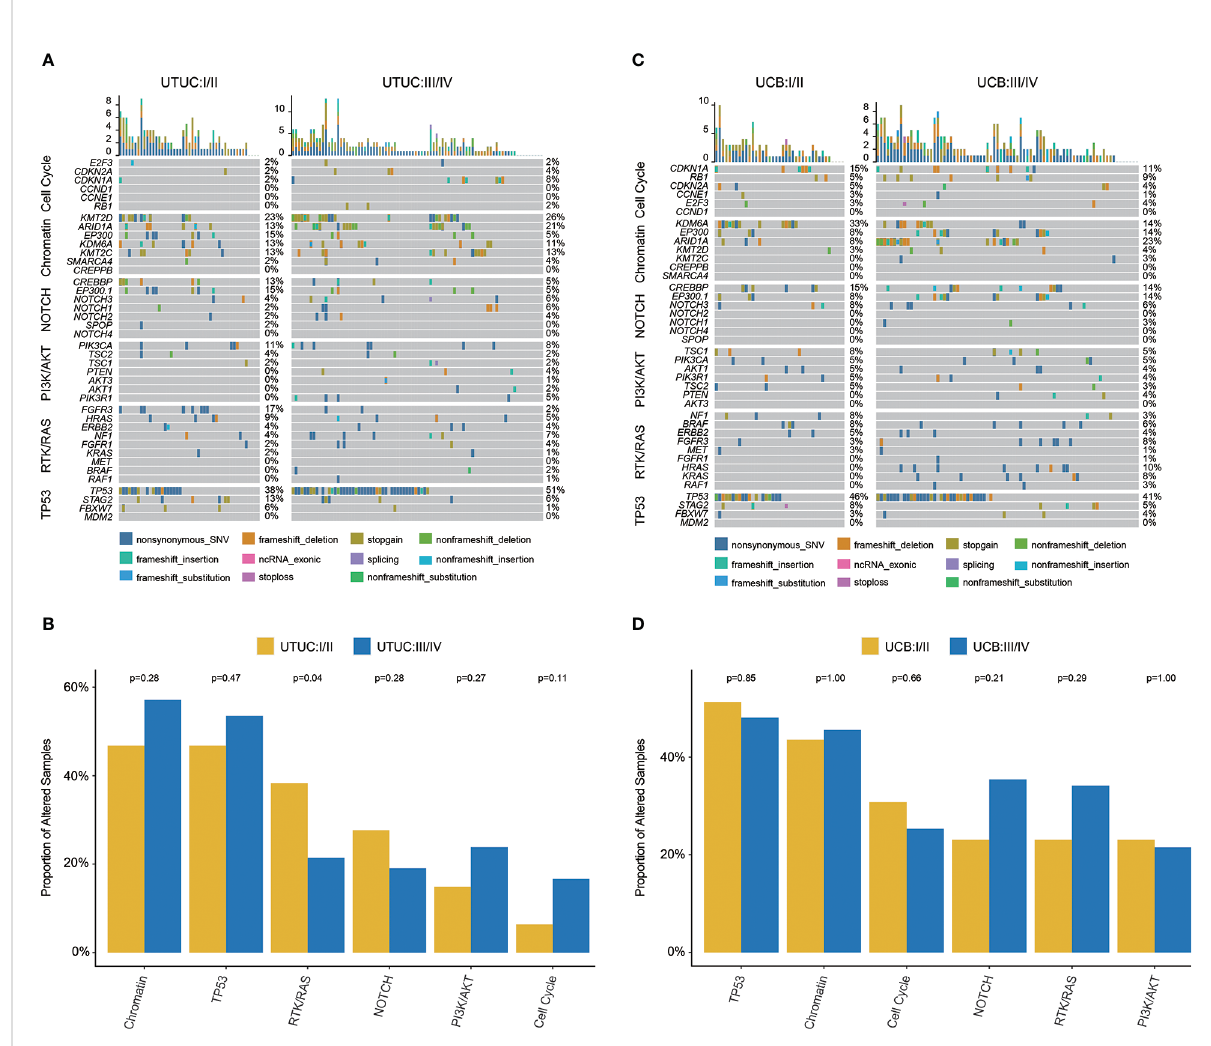
FIGURE 4 Genomic landscape, strati fi ed by clinical stages and molecular pathways, of Chinese UTUC and UCB. (A) Differences of prevalent GAs between early-stage and advanced tumors in UTUC. (B) Comparison of the differences in the prevalence of commonly altered molecular pathways between early-stage and advanced tumors in UTUC. (C) Differences of prevalent GAs between early-stage and advanced tumors in UCB. (D) Comparison of the differences in the prevalence of commonly altered molecular pathways between early-stage and advanced tumors in UCB. UTUC, upper tract urothelial carcinoma; UCB, urothelial carcinoma of the